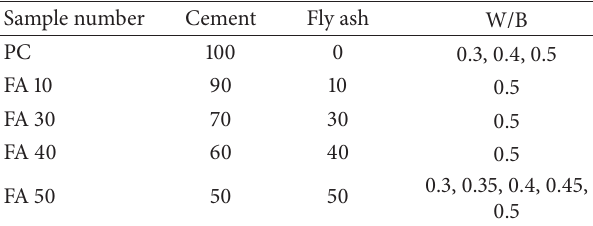
Table 2: Mix proportions of blended materials,